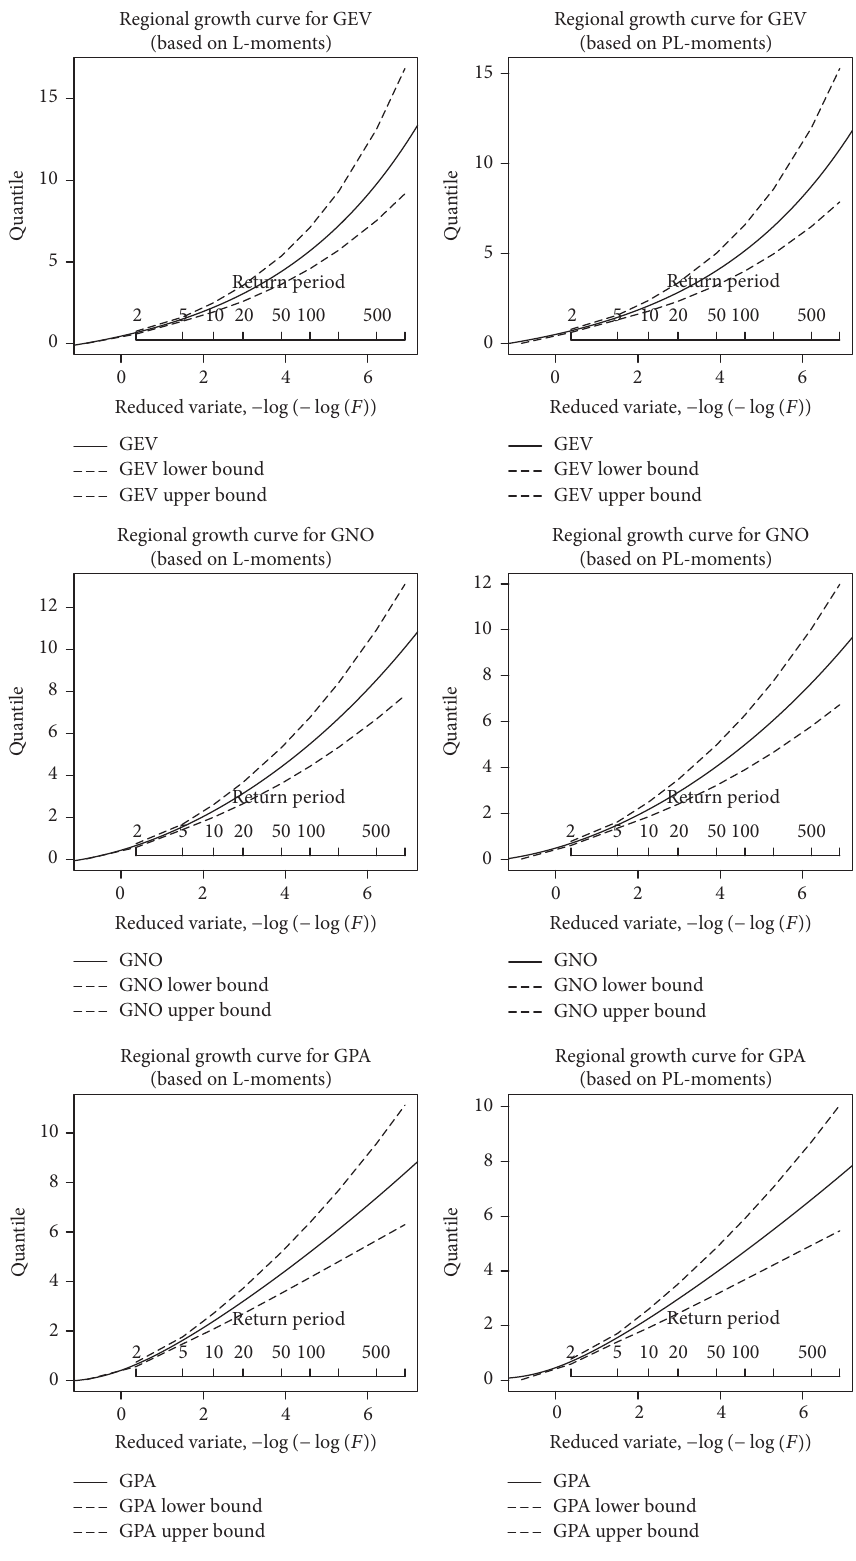
Figure 6: Regional growth curves of the three distributions for L-moments and PL-moments with their 90% error bounds for sample size of